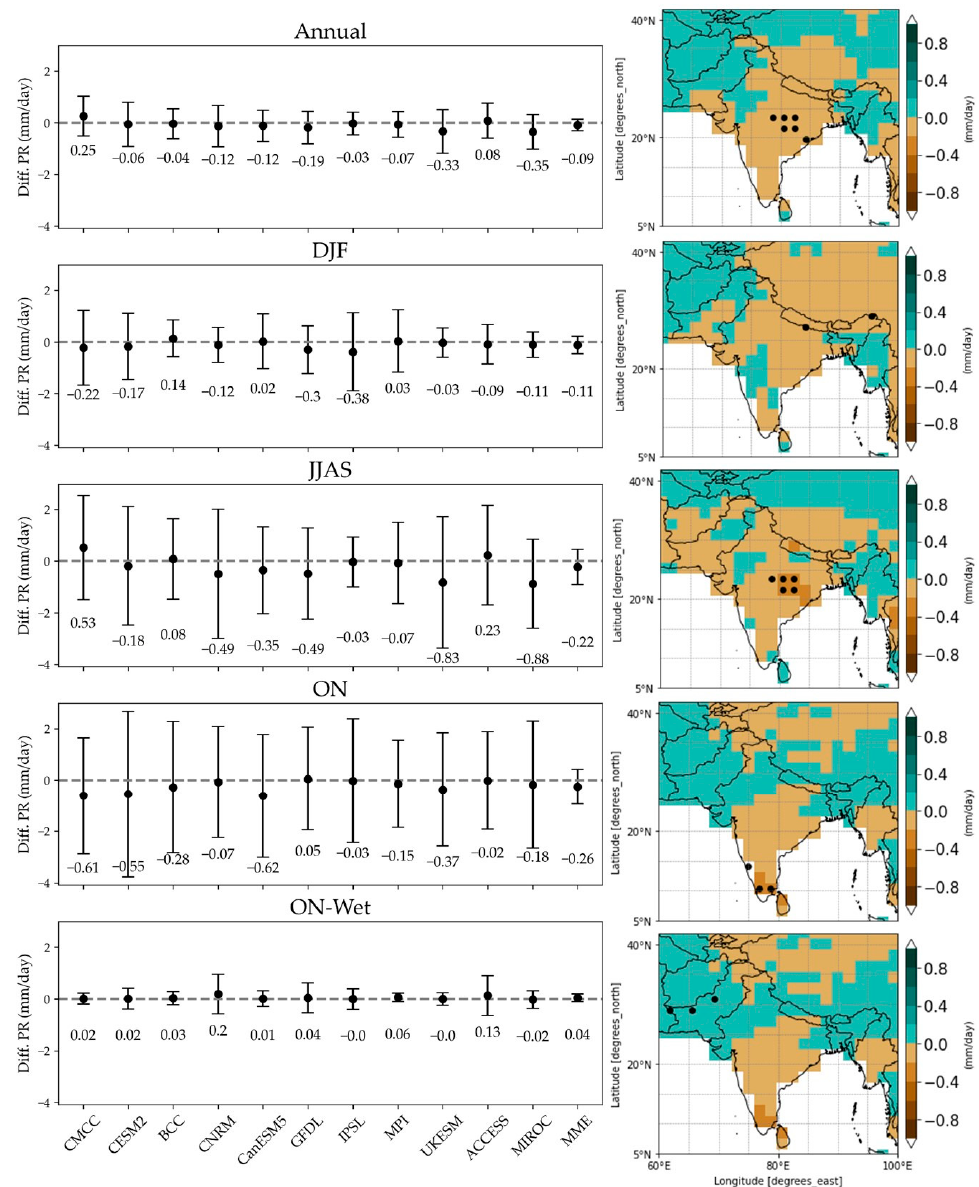
Figure 9. Same as Figure 7 but for changes in PR. The brown shades illustrate drying and the green shades show we tt ing.